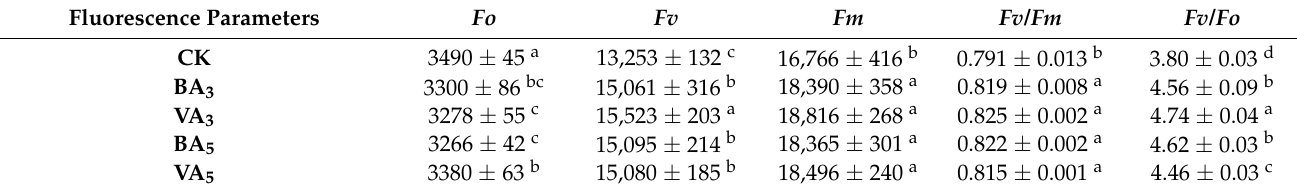
Table 3. Effect of BA and VA rates on chlorophyll fluorescence